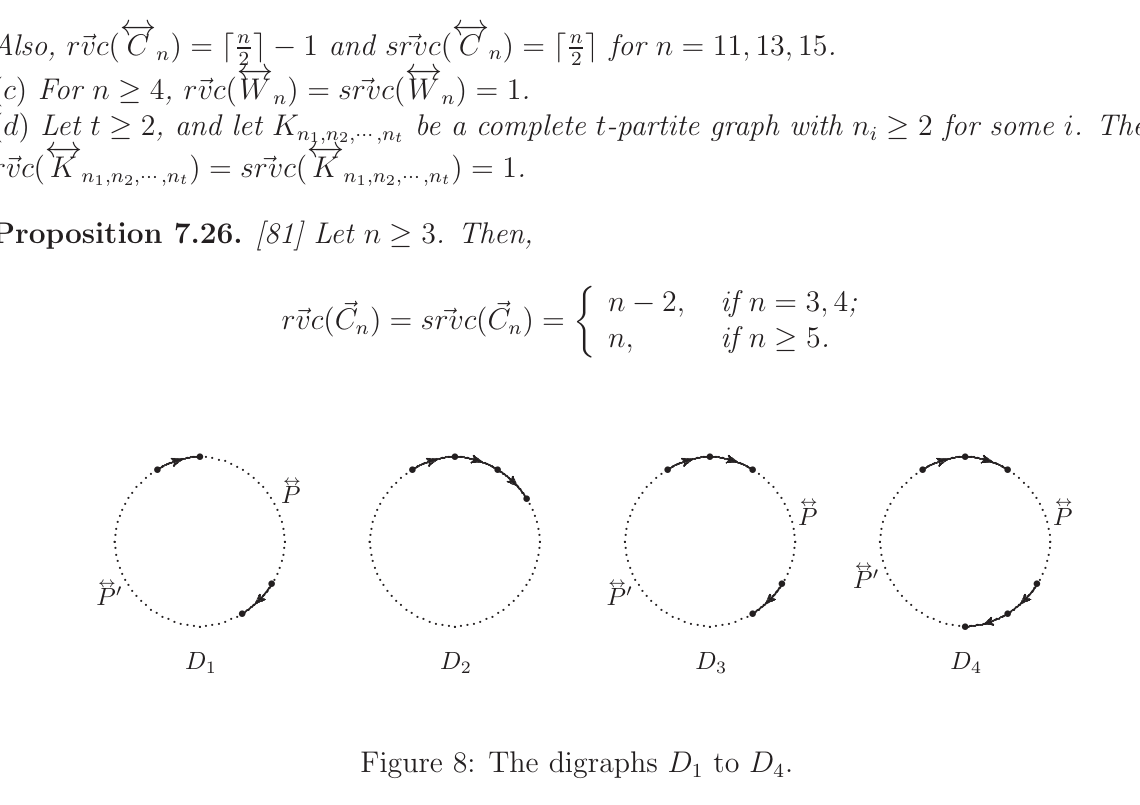
Figure 8: The digraphs D